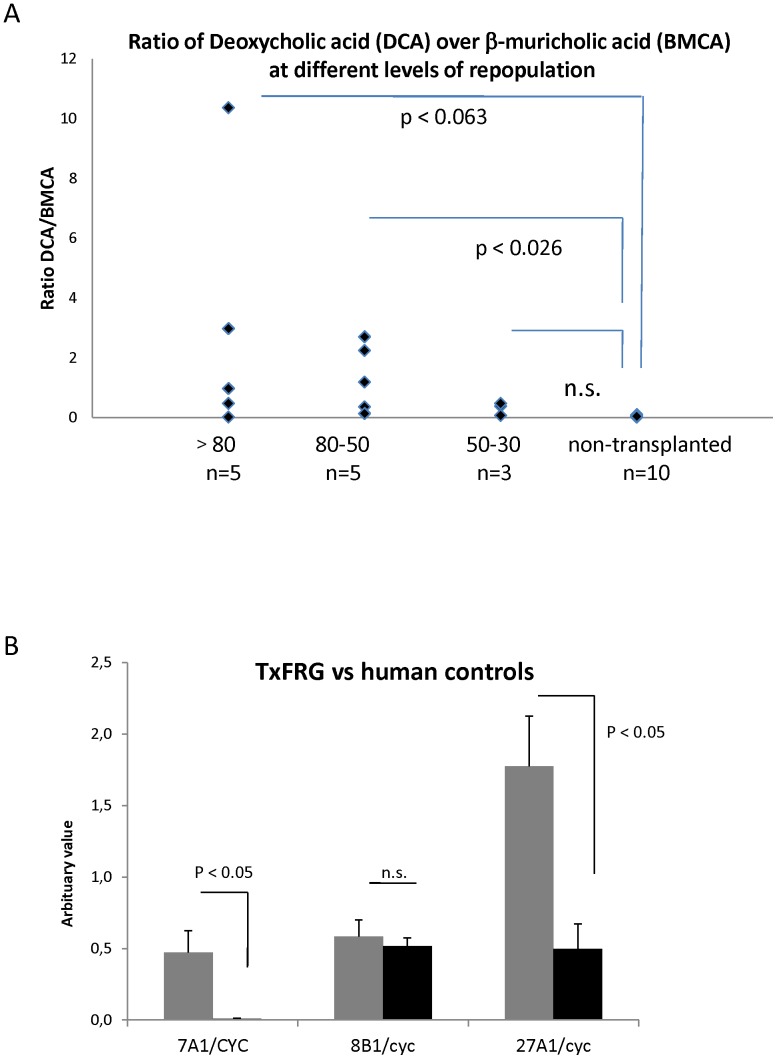
Bile acid composition and expression of enzymes of the bile acid synthesis pathway.A, Ratio of deoxycholic acid (DCA) over beta-muricholic acid (BMCA) in high (<80%), moderate (50–80%) or low (30–50%) population compared to non-transplanted FRG mice. Statistics were performed by a 1-way ANOVA on log-transformed data followed by Dunett’s test. The overall significance was p = 0.023 (all different vs control). B, RNA expression of CYP7A1, CYP8B1 and CYP27A1 in hepatocytes, normalized to cyclophillin analyzed by quantitative real time PCR. Expression of human genes were analyzed in hepatocytes isolated from humanized FRG (Tx-Mice) and compared to isolated human hepatocyte controls (Human). Statistics were performed by a non-parametric Mann-Whitney U test.